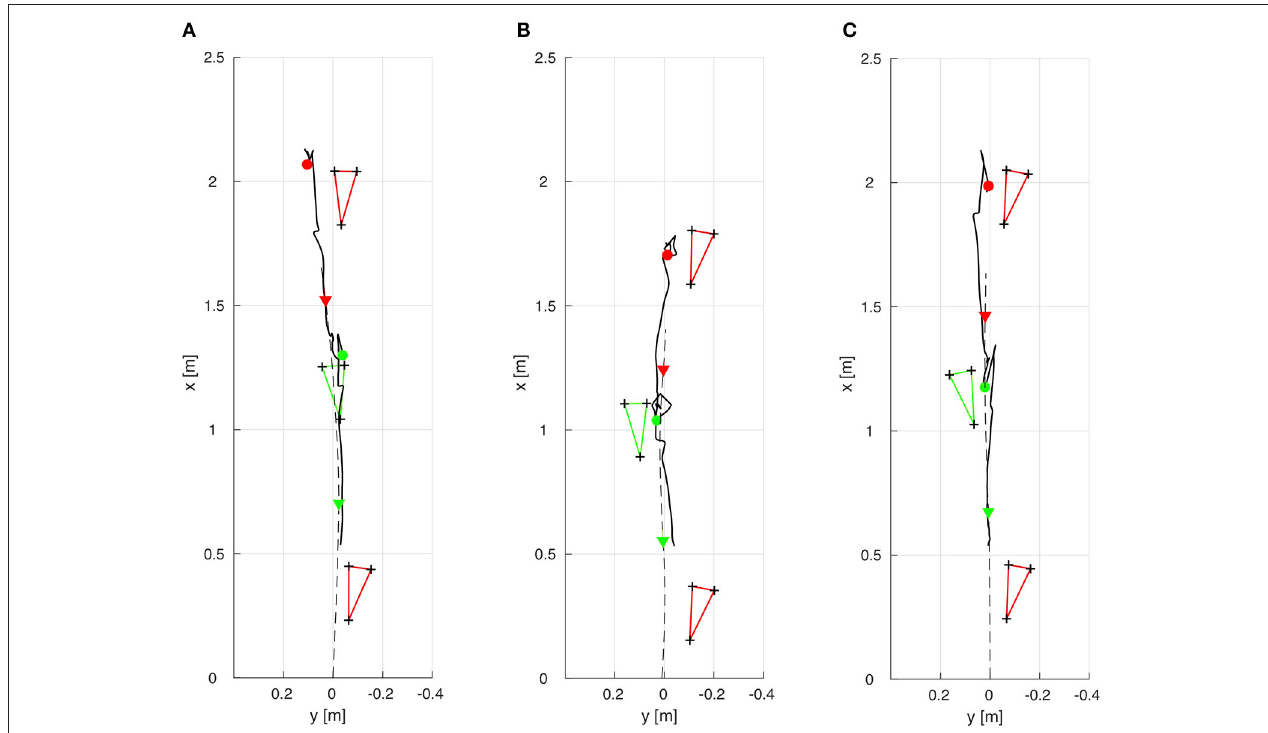
FIGURE 6 | Footprints of the right (red) and left (green) feet as well as the trajectories of the ICaP (solid) and the ground projection of the COM (dashed) in the xy -plane. The ICaP positions ( ◦ ) are illustrated right at the heel strike of the right and left feet, respectively, along with the COM positions ( ▽ ) at the same time instances. (A) Unimpaired female, (B) Unimpaired male, (C) Male with prosthesis.